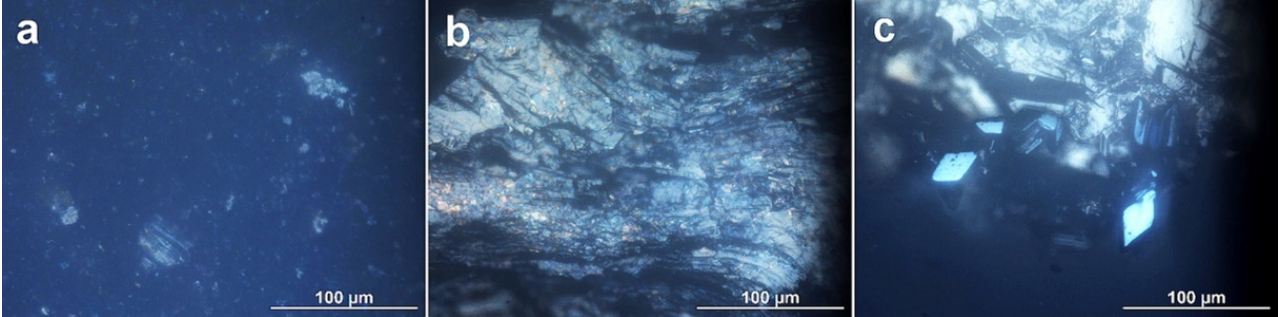
Figure 1. Optical micrographs of GBS_1 ( a ), GBS_2 ( b ), and GBS_3 ( c ).